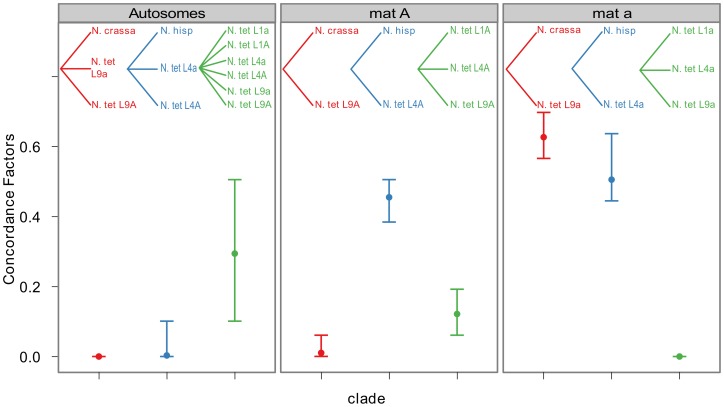
Bayesian concordance factors of selected clades, for the autosomes and the mating-type chromosomes (mat A and mat a) of Neurospora.Bayesian concordance factors and 95% credibility intervals (error bars) estimated for 10 loci on the autosomes and 16 loci on the mat chromosomes. Concordance factors are given for the three hypotheses illustrated as clades in the plot, red: N. tetrasperma L9 sister species to N. crassa; blue: N. tetrasperma L4 sister species to N. hispaniola; green: N. tetrasperma monophyletic. The results displayed were calculated with the prior alpha set to 1.